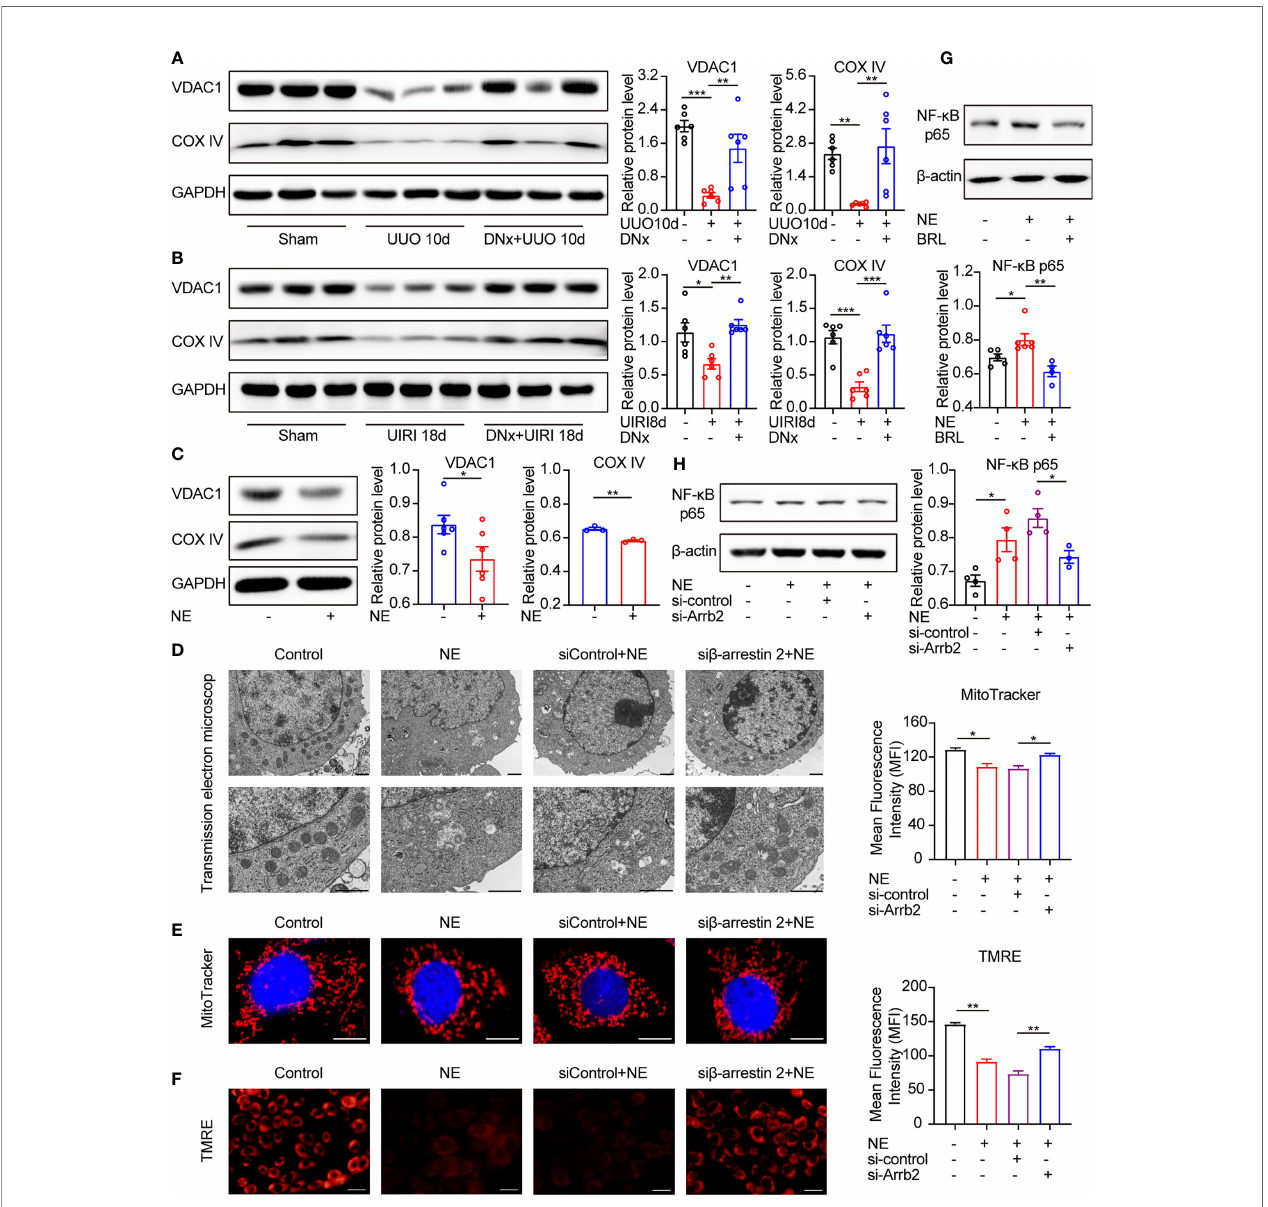
FIGURE 7 | a 2A -AR/ b -arrestin2/NF- k B signaling contributes to mitochondrial dysfunction and cellular senescence. (A, B) Renal denervation (DNx) or sham operation was performed 2 days before UUO or UIRI in the left kidneys of mice. Representative Western blotting of VDAC1 and COX IV in each group with densitometry analysis (n=6). (C) Representative Western blotting of VDAC1 and COX IV in TKPTS cells treated with PBS or NE (10 nM) for 48 hours with densitometry analysis (n=3 – 6 in each group). (D – F) TKPTS cells were transfected with scrambled siRNA (si-control) or b -arrestin2 siRNA (si-Arrb2) for 24 hours and then incubated with NE (10 nM) for 48 hours. Mitochondrial ultrastructure was observed by transmission electron microscope (D) . Scale bar, 1 m m. Mitochondrial mass was tested by MitoTracker deep red probe (100nM) staining (E) . Scale bar, 50 m m. Mitochondrial membrane potential was examined by TMRE fl uorescent dye (200 nM) (F) . Scale bar, 20 m m. (G) Representative Western blotting of NF- k B p65 in TKPTS cells incubated with PBS, NE, and NE+BRL (10 m M) with densitometry analysis (n=4 – 6 in each group). (H) Representative Western blotting of NF- k B p65 in TKPTS cells of PBS, NE, and NE+si-control, NE+si-Arrb2 with densitometry analysis (n=3-4 in each group). *P < 0.05, **P < 0.01, ***P < 0.001. Bars represented means ±